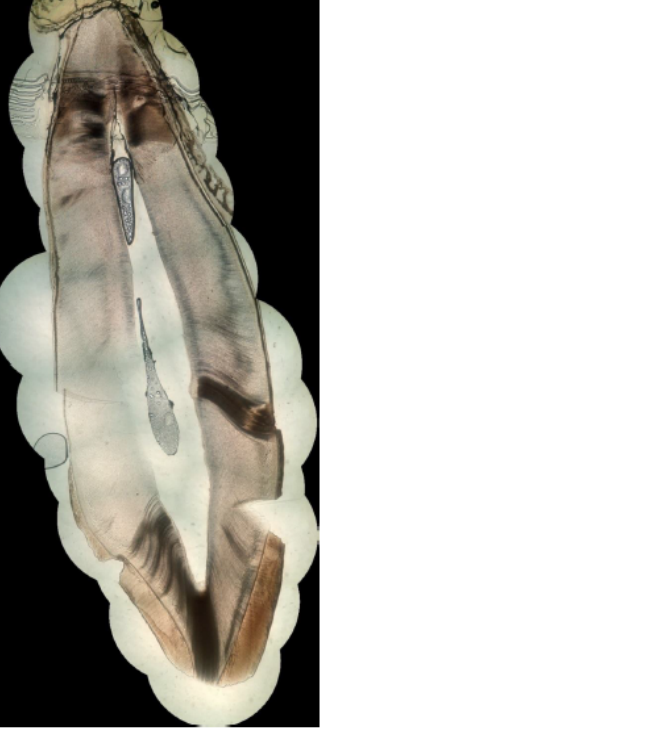
Figure 8. A fourth example of high-resolution stitched picture of a sagittal cross-section of a permanent maxillary central